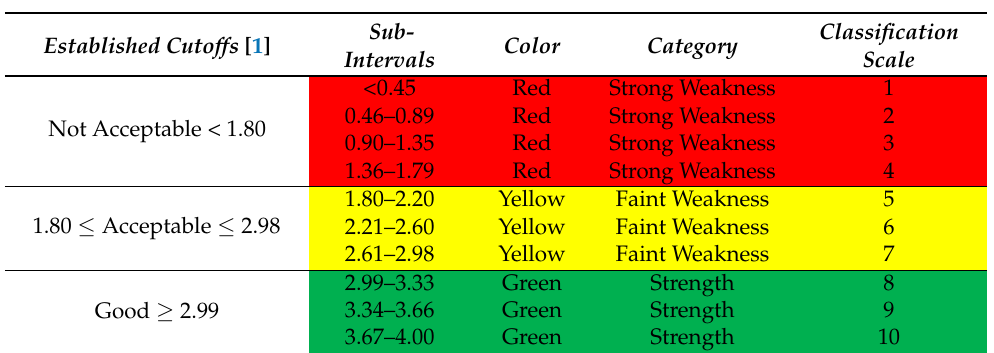
Table 1. Comparison between the established cutoffs and the sub-intervals. The established cutoffs allow the synoptic reading of the first Excel sheet (streetlight color system), while the sub-intervals allow us to give the classification scale